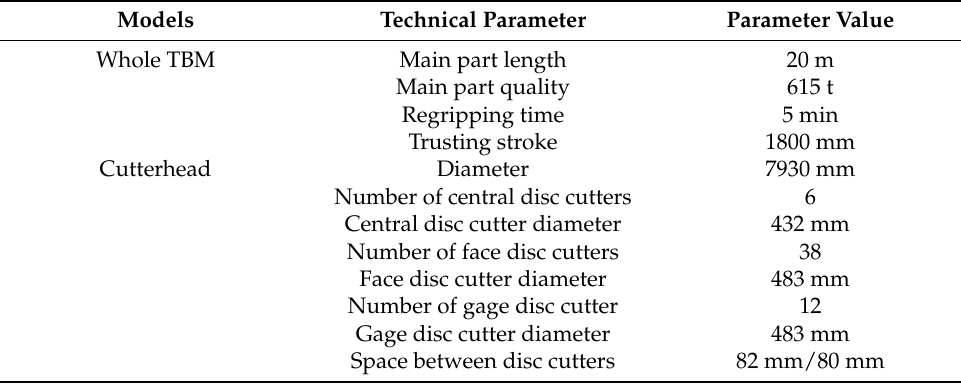
Table 1. Technical parameters of the studied TBM.